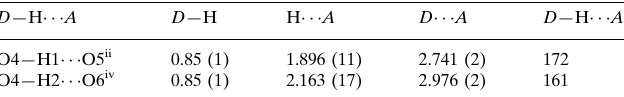
Hydrogen-bond geometry (A˚ , (cid:2)